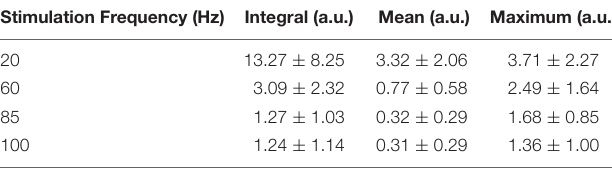
TABLE 3 | Averaged results across all mice for the frequencies 20, 60, 85, and 100 Hz.